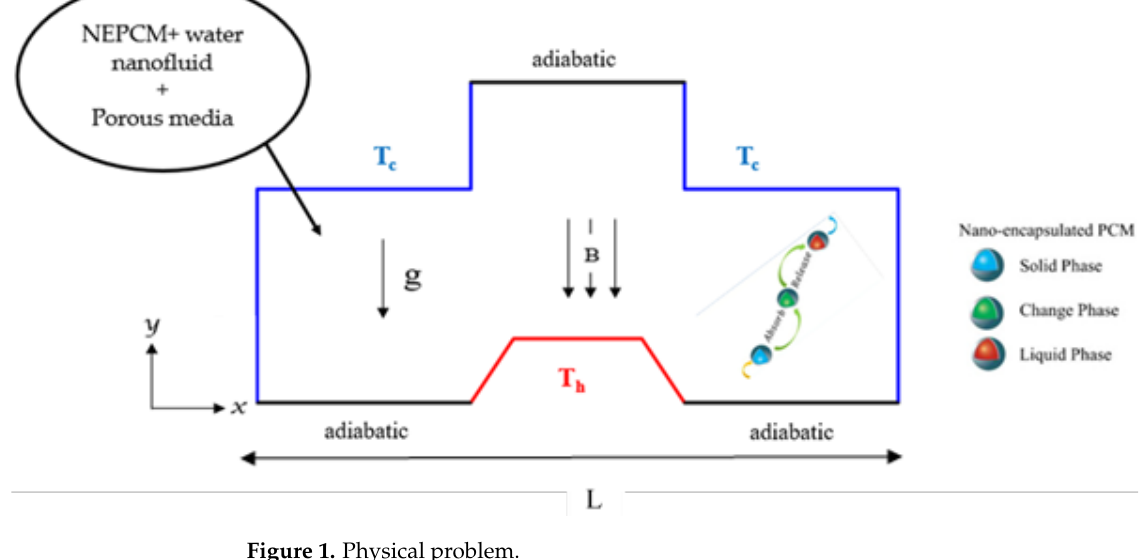
Figure 1. Physical problem. Table 1. Thermophysical properties of the shell and core of the NEPCMs and the base fluid. Material